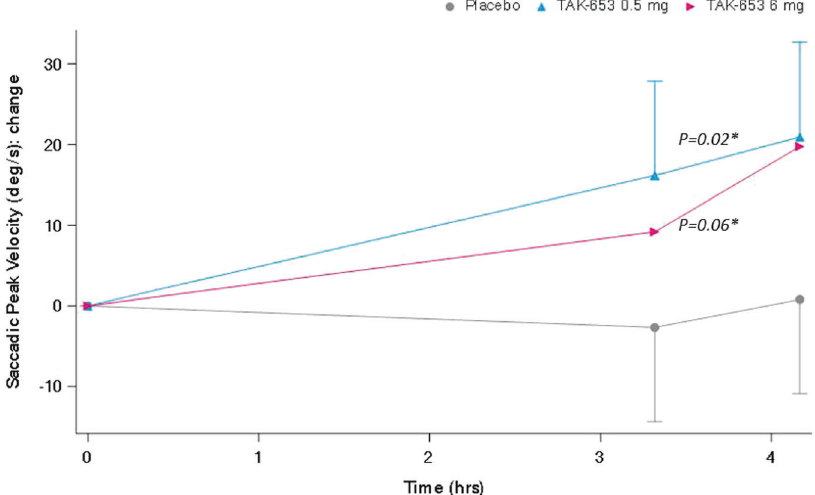
Fig. 5 Saccadic peak velocity. Saccadic peak velocity: change from baseline time effect pro fi le of the least square (LS) mean